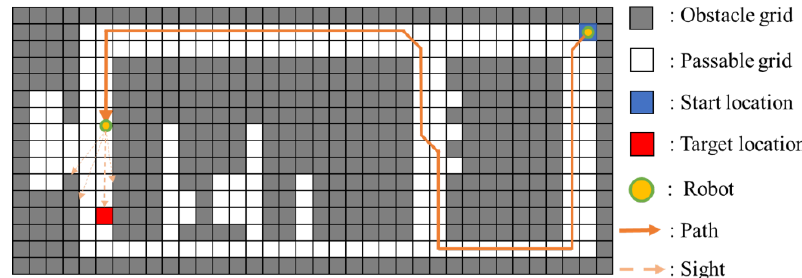
Figure 16. The distance reduction rate of path obtained by OA relative to RBA and GA.